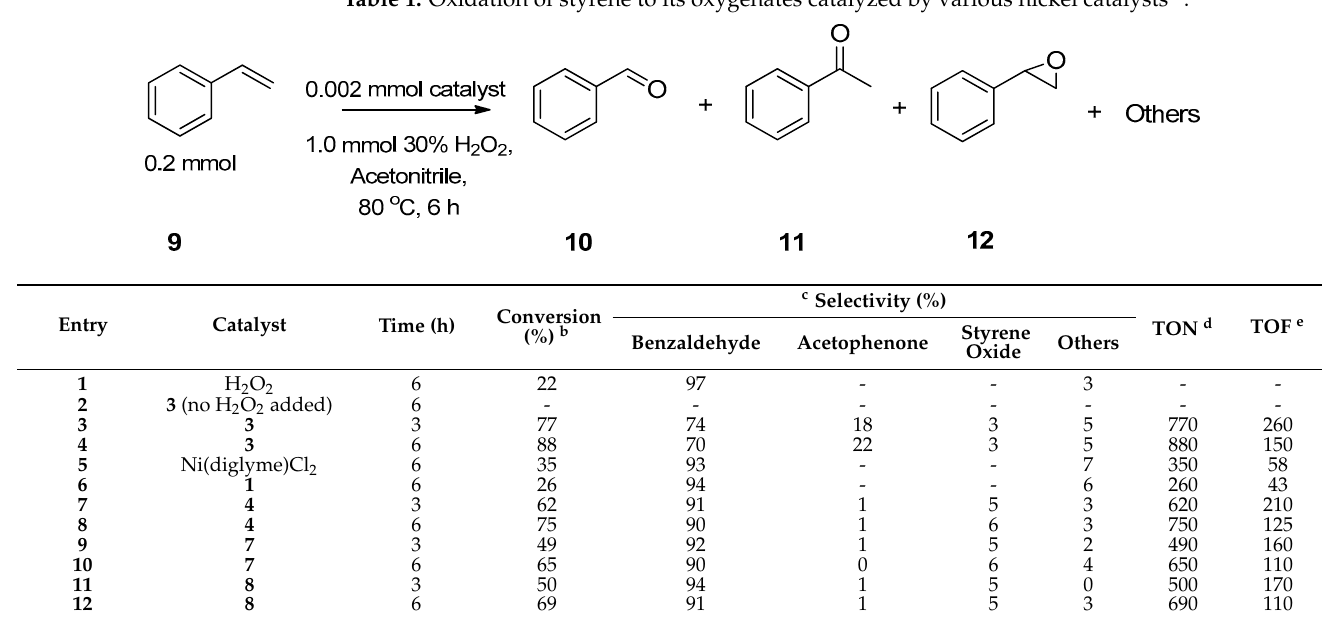
Table 1. Oxidation of styrene to its oxygenates catalyzed by various nickel catalysts a .